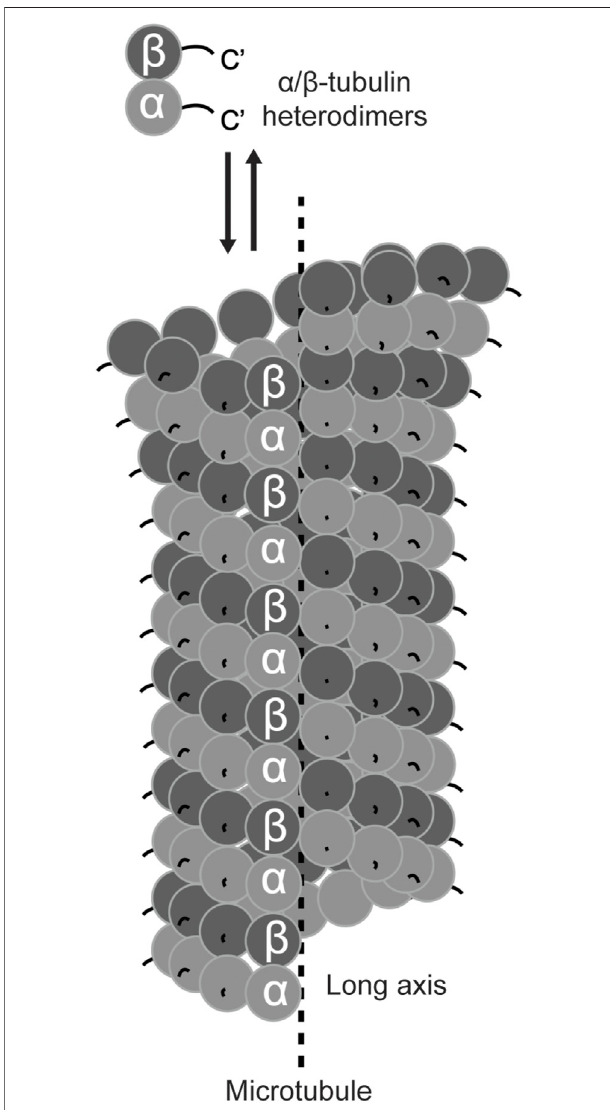
FIGURE 2 | Schematic of α / β -tubulin heterodimers and a microtubule. The structured cores of α - (light grey) and β - (dark grey) tubulin are shown in circles. The unstructured C-terminal tails are exposed on the surface of the microtubule.